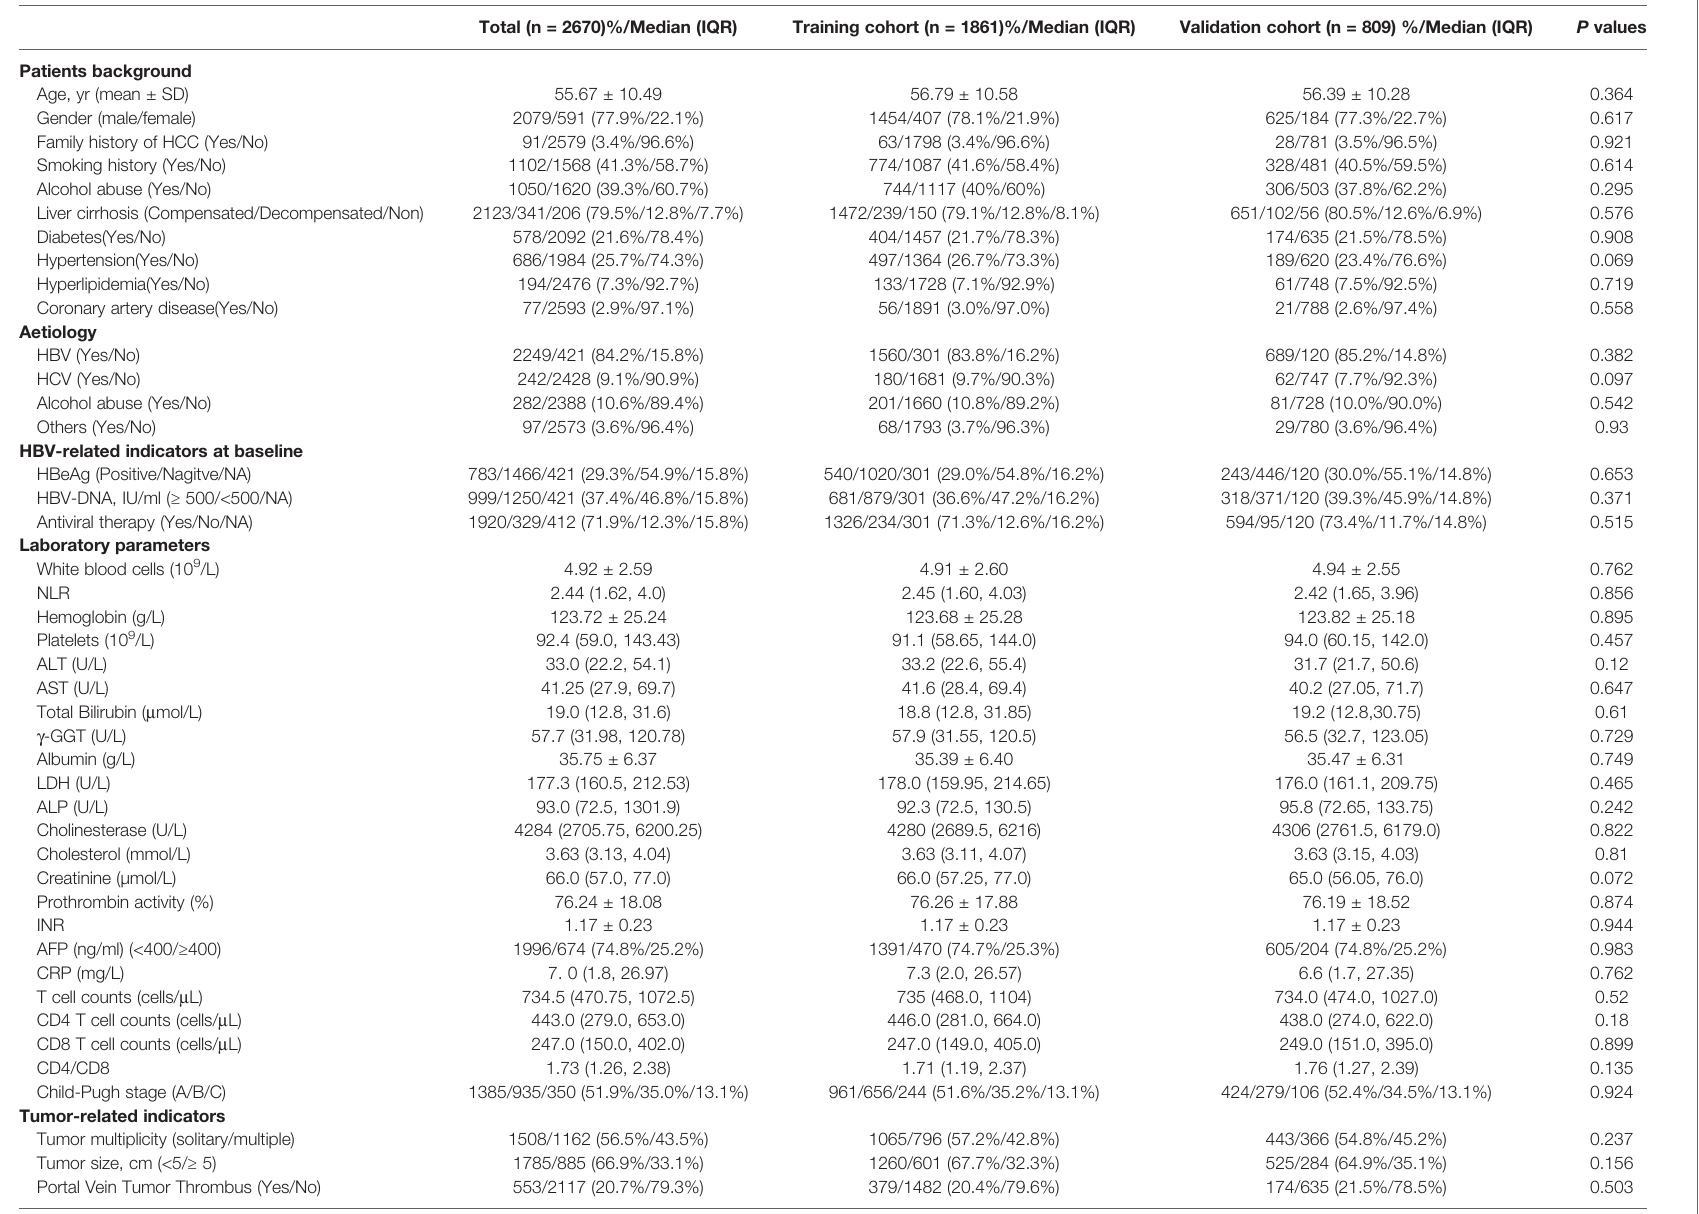
TABLE 1 | Baseline demographics and clinical characteristics of patients with hepatocellular